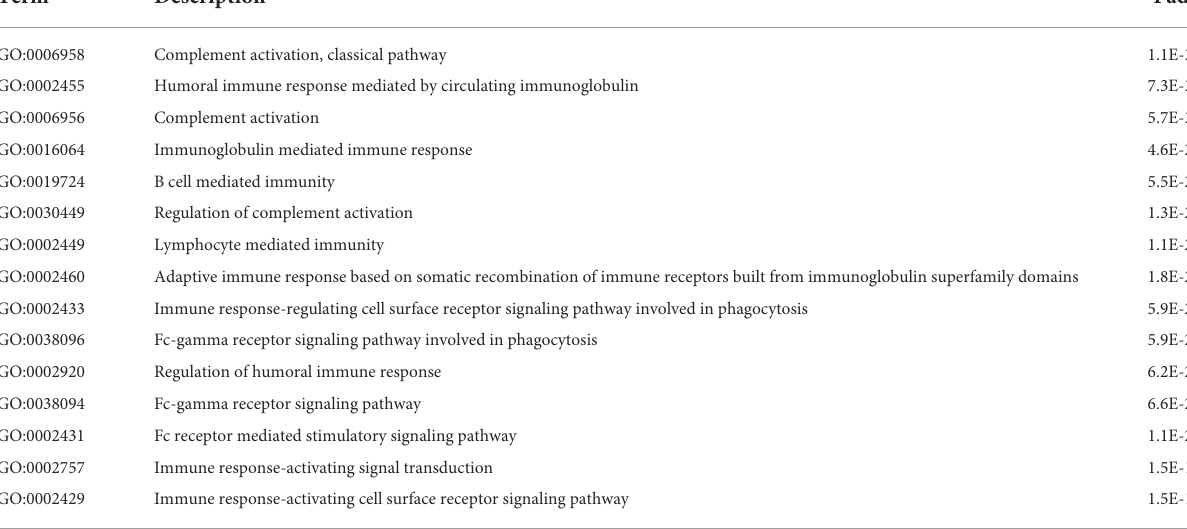
TABLE 4 Gene ontology (immune system process) analysis of 59 common differentially expressed genes (top 15). Term